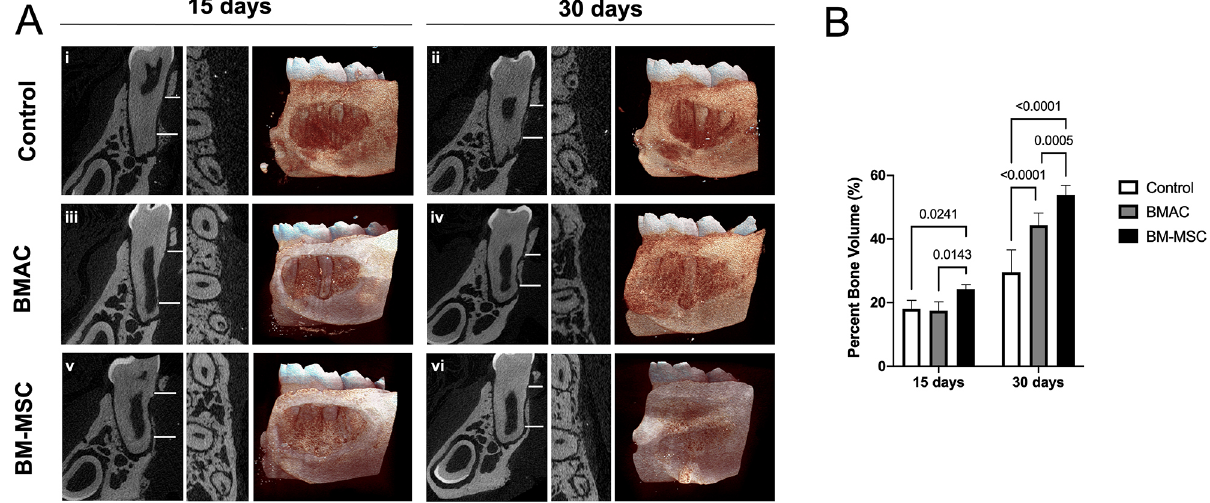
Figure 2- Micro-computerized tomography (μCT) results of the Control, BMAC, and BM-MSC groups in the regeneration of fenestration periodontal defects in 15 and 30 days after surgery. (A) μCT images in 2D longitudinal and coronal axis and 3D reconstructed images within 15 and 30 days of spontaneous healing (i, ii), and BMAC (iii, iv) and BM-MSCs (v, vi) treatments. White lines represent the longitudinal limits of the defect. (B) Histogram reporting the bone volume percentage (Bv/Tv, %). Considering α=5%, the presence of BM-MSCs in suspension form significantly affected bone formation in 15 and 30 days. BMAC also influenced bone volume within 30 days compared to spontaneous healing. Means and standard deviations of the groups and experimental times: 15 days: Control (18.01±2.71), BMAC (17.52±2.74), BM-MSC (24.27±1.38); 30 days: Control (29.55±7.08), BMAC (44.32±3.83), BM-MSC